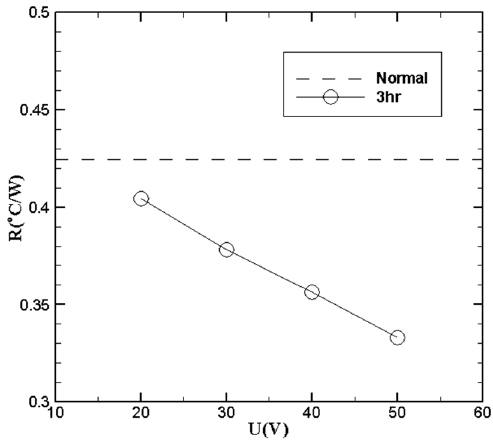
Figure 6. Variation of the overall thermal resistance with the anodizing voltage under an input heat power of 100 W at a treatment time of 3 h.